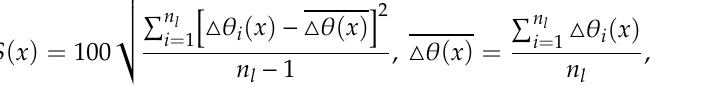
Table 7. Error sensitivity of different error sources.